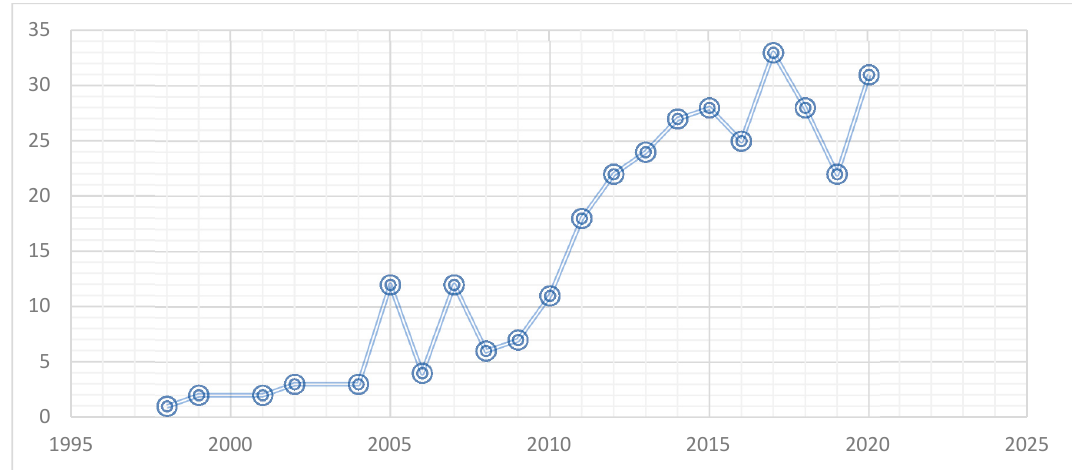
Figure 2. Trends of publications in the common area of food security and social capital from 1998 to 2020.